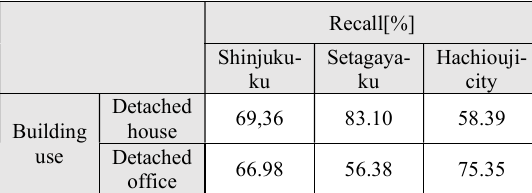
Table 8 . Recall per building